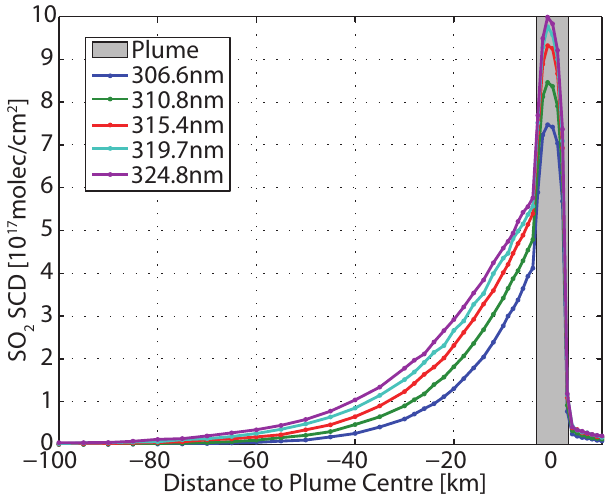
Fig. 9. Wind direction and altitude of plume centre derived from the ground based measurements, showing the stable meteorological conditions on 24 April 2010. Values derived by the two stationary scanning instruments according to (Galle et al., 2010) are depicted as blue asterisks, red circles show results from the car traverses (up- per graph). Also the mean altitude of the airplane is indicated for all approaches by red pluses (bottom graph). Note that the different types of measurements were conducted at different distances to the plume, which could explain the slightly differing values.